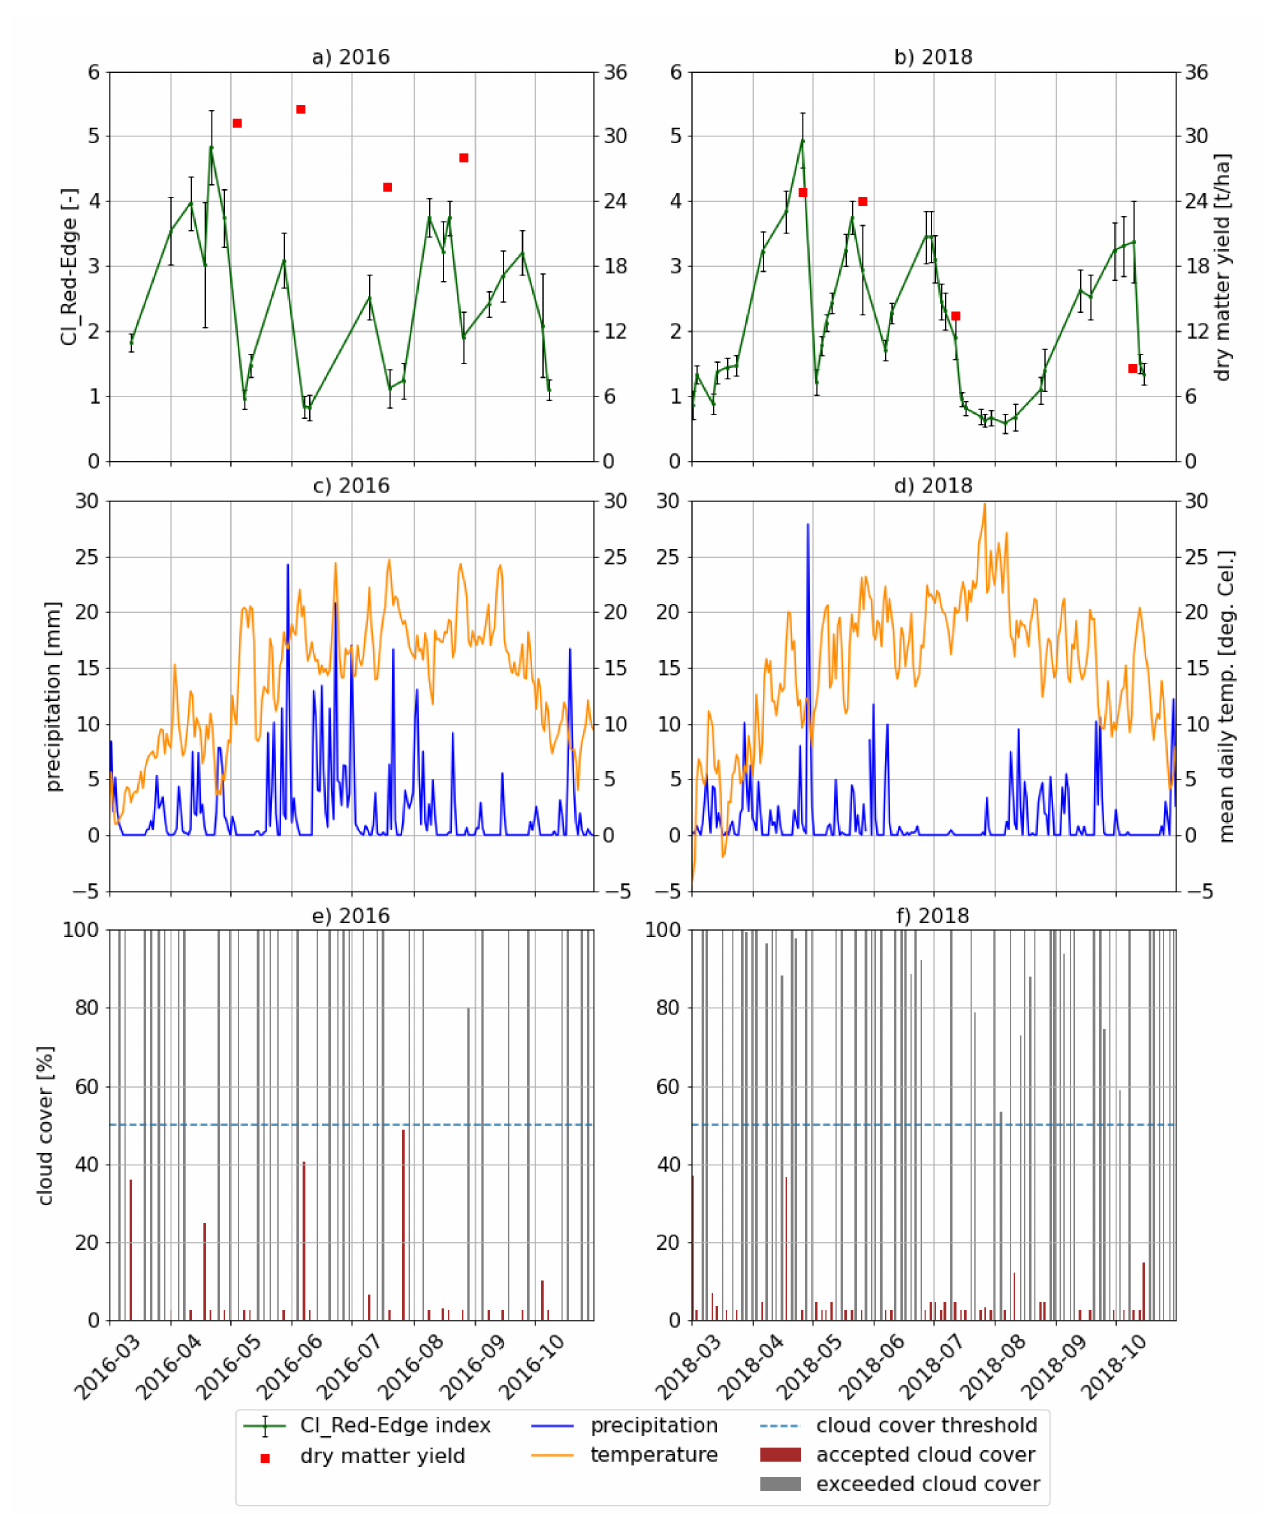
Figure 7. Time series over growing seasons 2016 and 2018: CI Red-Edge index and dry matter yield for parcel Lenzen grosse Weide ( a , b ), total precipitation (mm) and mean daily temperature (deg. C) for the area of Kleve ( c , d ), and cloud cover percentages for parcel Lenzen grosse Weide ( e , f